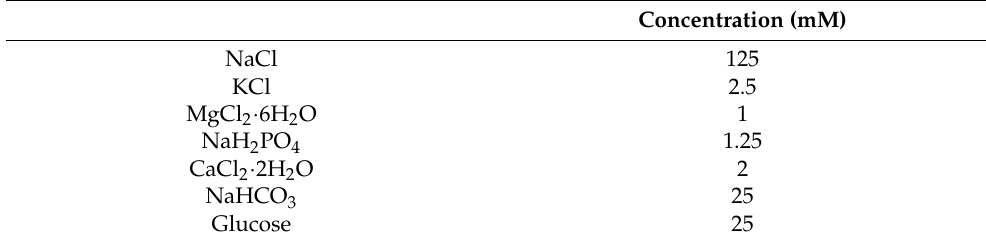
Table 1. Composition of artificial cerebrospinal fluid (aCSF)